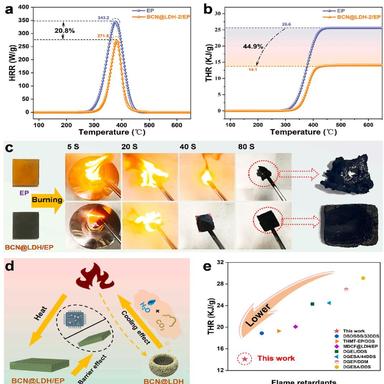
(a) Peak heat release rate (HRR) and (b) total heat release curves (THR) of pure EP and BCN@LDH-2/EP from MCC tests. (c) Digital images of EP and BCN@LDH/EP samples taken from the vertical burning test. (d) The flame-retardant mechanism for BCN@LDH/EP. (e) THR of BCN@LDH/EP compared with other epoxy resin-based composites.